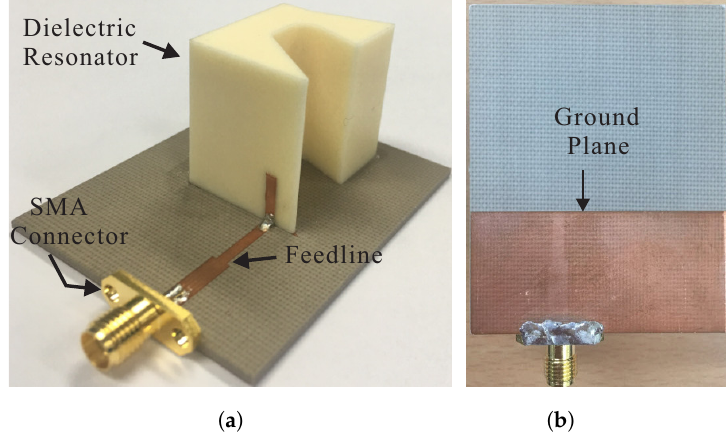
Figure 6. Photograph of the proposed antenna: ( a ) panoramic view; ( b ) bottom